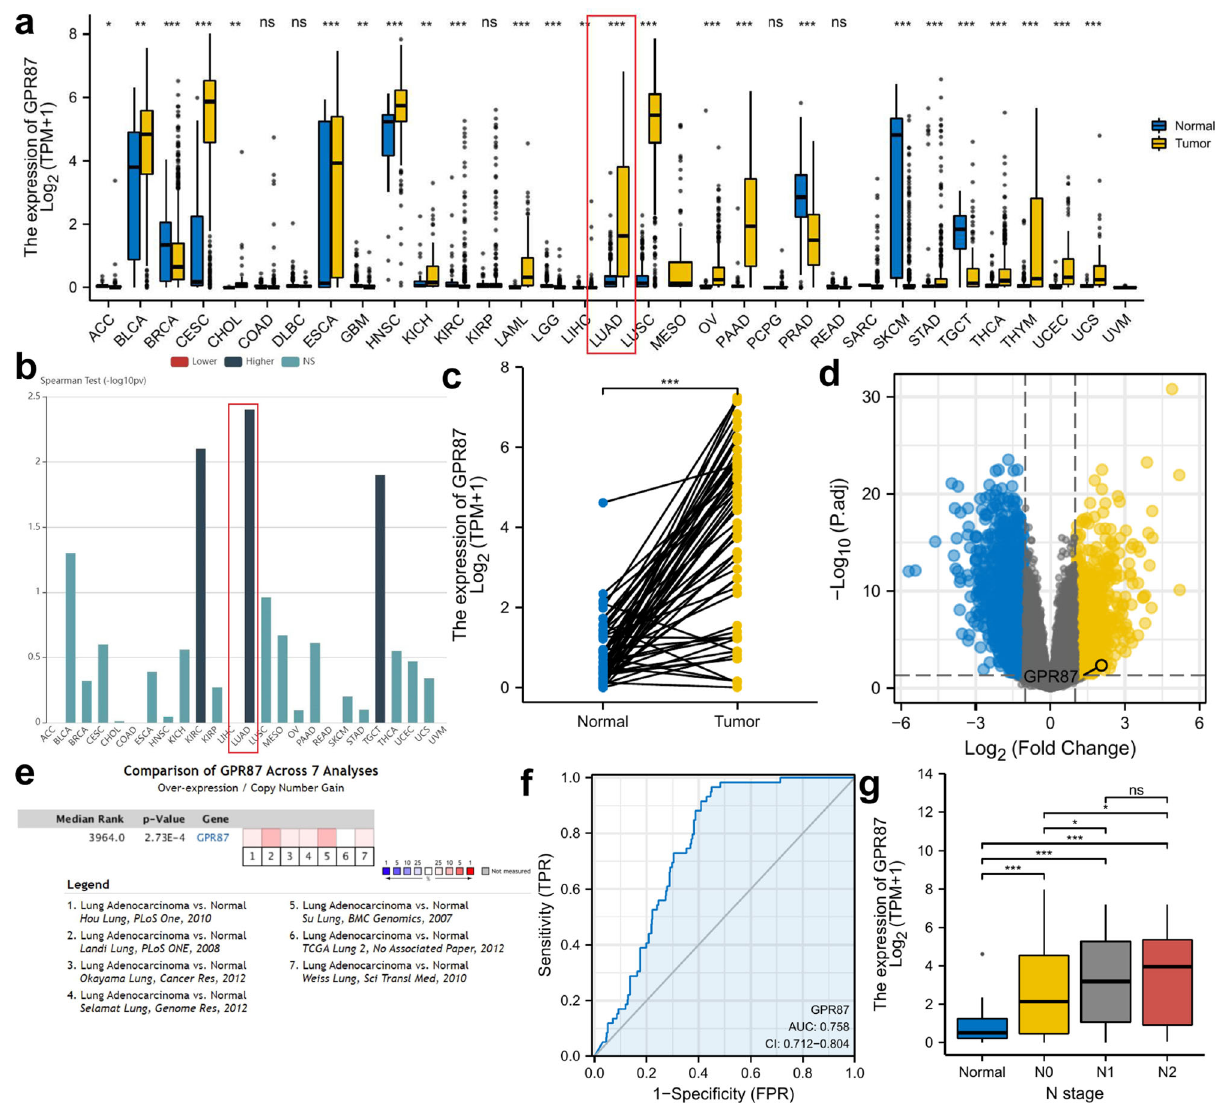
Fig. 1 GPR87 expression in LUAD and adjacent normal tissues. a Expression of the GPR87 gene in pan-cancer using TCGA data. b The relationship between GPR87 and the clinical stages of all TCGA cancers using TISIDB. c GPR87 expression levels in 57 paired normal and tumor and tissues. d Volcano plot of differential analysis in GSE31210. e Obtaining differential expression of GPR87 in lung cancer using Oncomine database. f ROC curve to verify the accuracy of GPR87 to distinguish tumor and normal tissues. g Detection of GPR87 expression levels concerning tumor lymph node